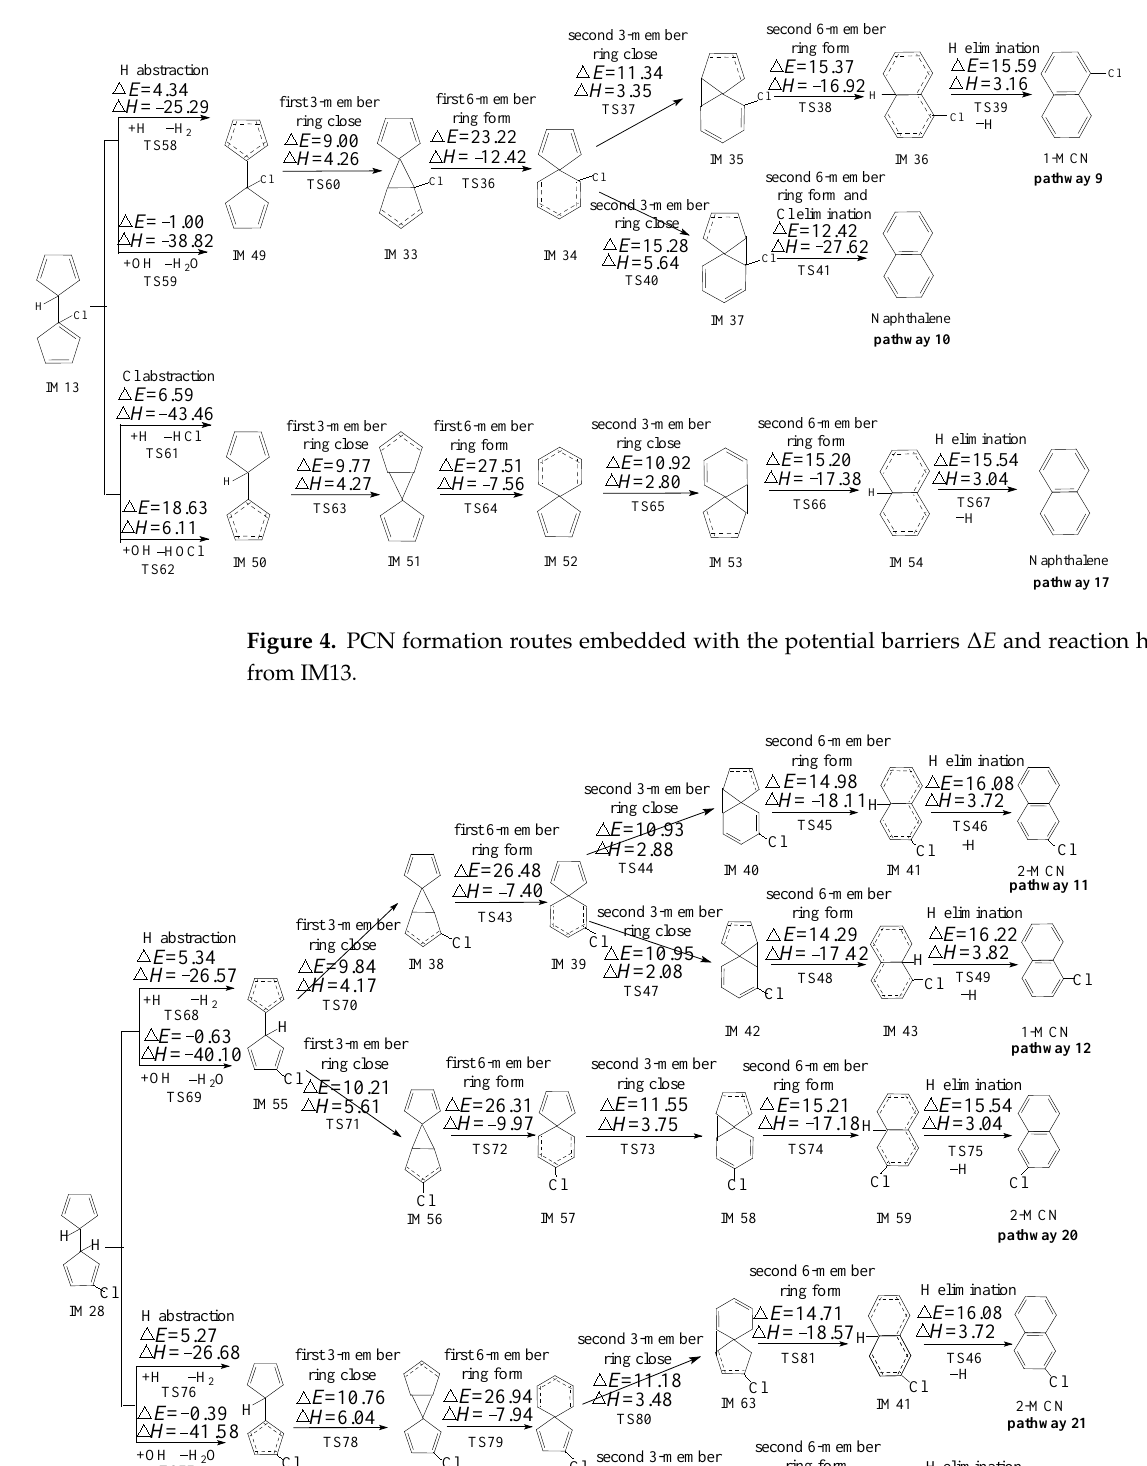
Figure 3. PCN formation routes embedded with the potential barriers Δ E (in kcal/mol) and reaction heats Δ H (in kcal/mol) from IM5. Δ H is calculated at 0 K.